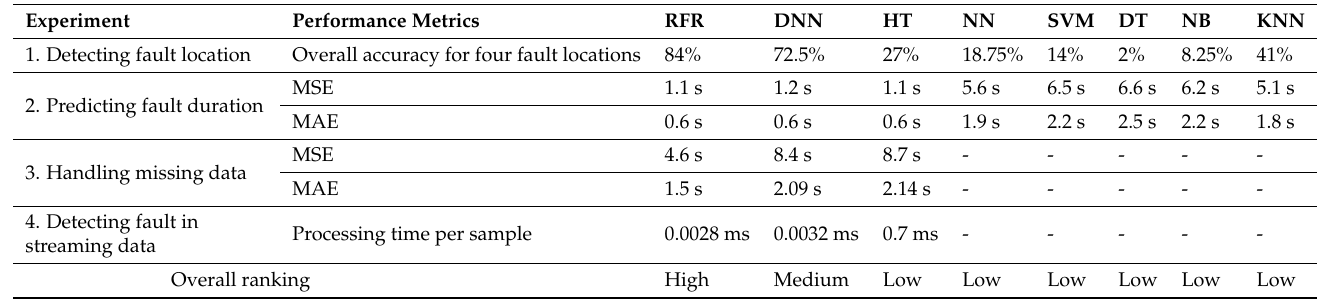
Figure 8. Comparison between DNN, HT, and RFR in terms of MSE. Table 4. Summary of the RFR’s performances compared to those of DNN, HT, NN, SVM, DT, NB, and KNN, obtained in the four